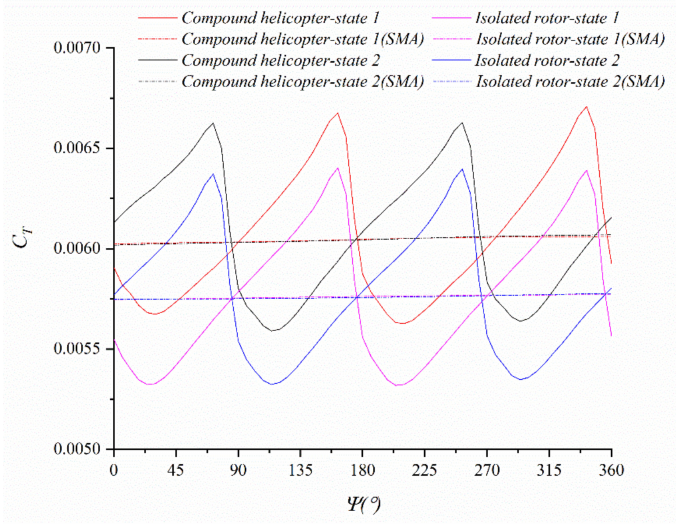
Figure 25. The compound coaxial helicopter lower rotor C T in